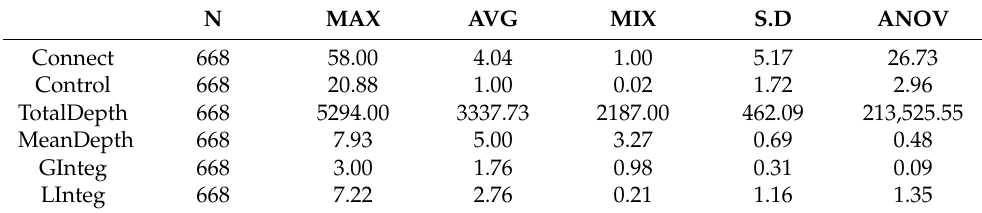
Figure 3. Street network accessibility metrics calculated by Axwoman. ( a ) Connect, ( b ) Control, ( c ) TotalDepth, ( d ) MeanDepth, ( e ) GInteg, ( f ) LInteg. Table 2. Statistics Table of Street Network Structure Accessibility